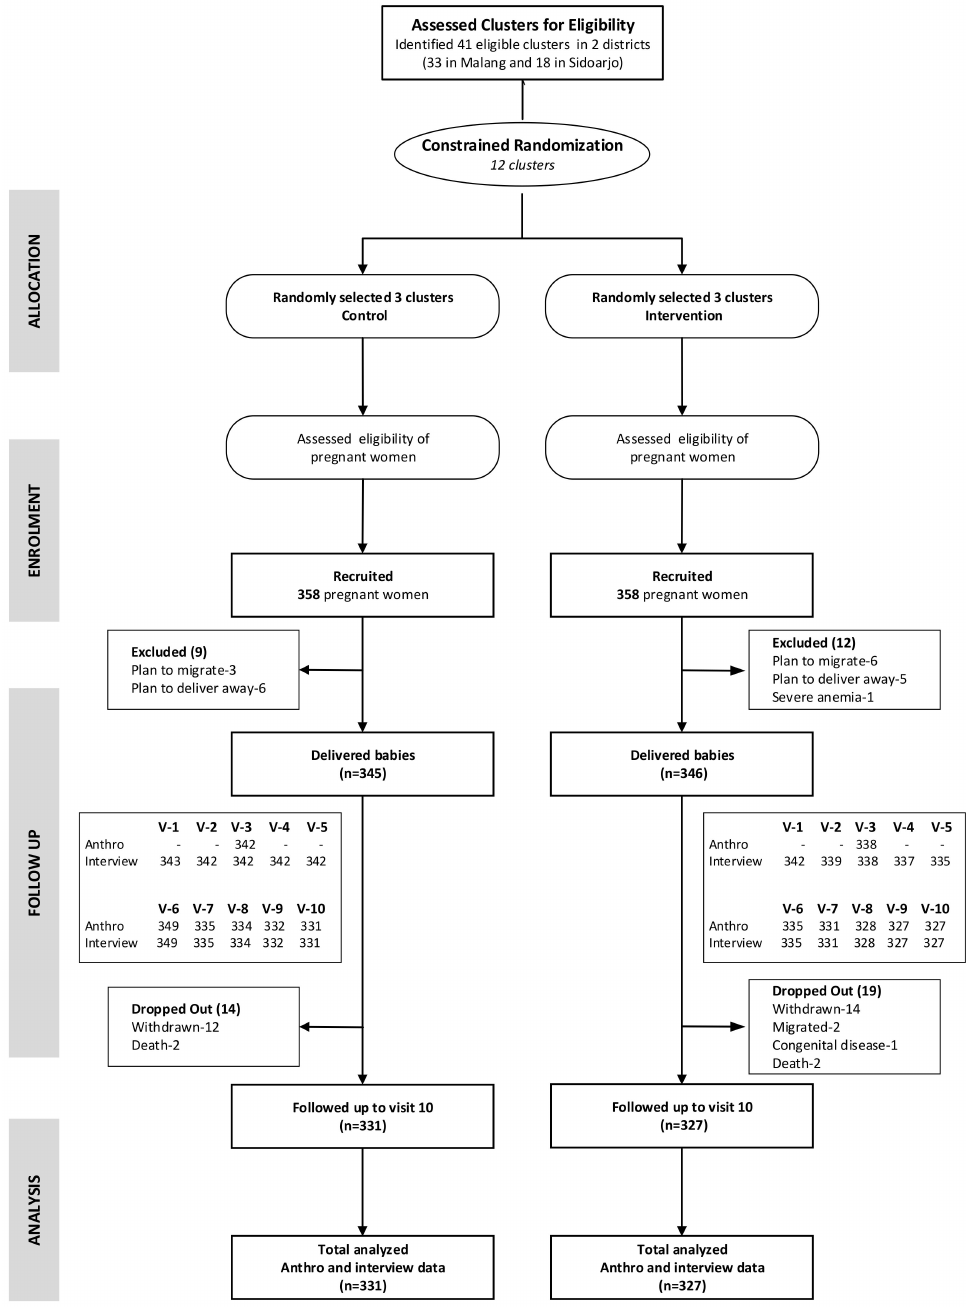
Figure 1. Participant flowchart of the